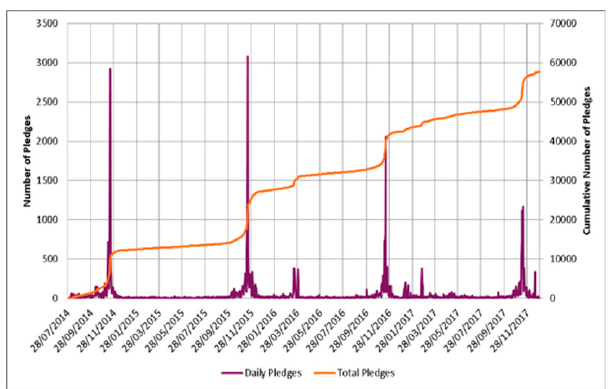
Figure 1. Daily number of AG pledges with the cumulative number of AG pledges from 2014 to 2017.